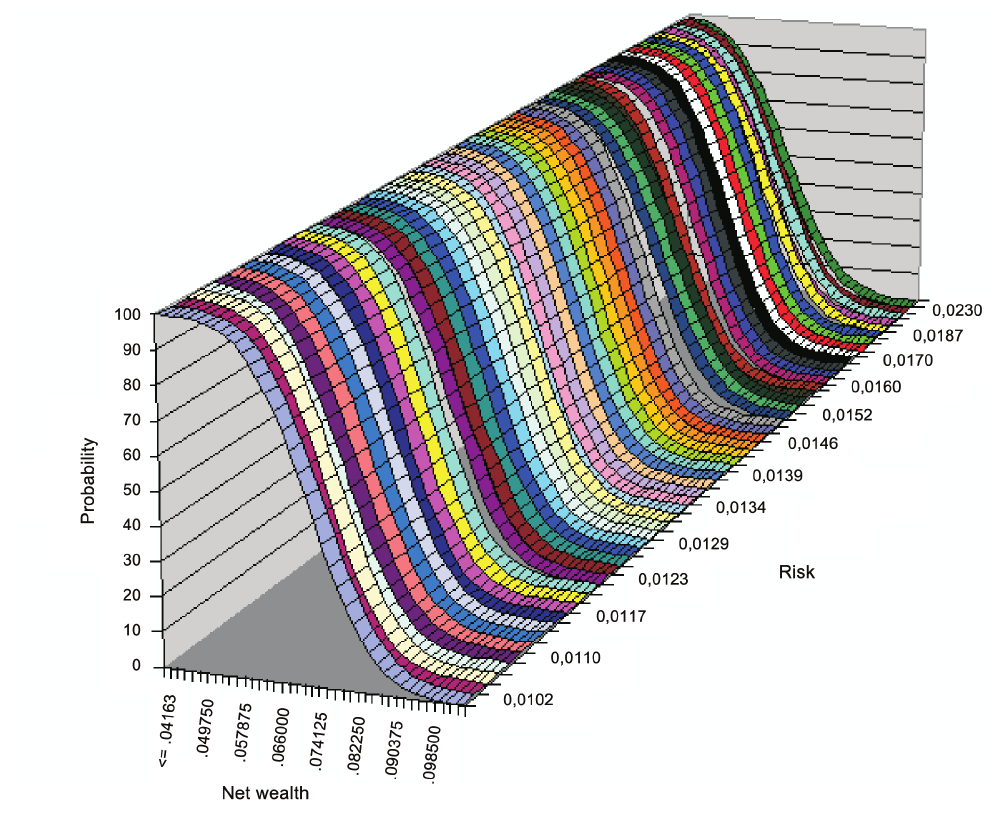
Fig. 3 . Three-dimensional surface of growth possibilities – growth rates, their guarantee and risk levels